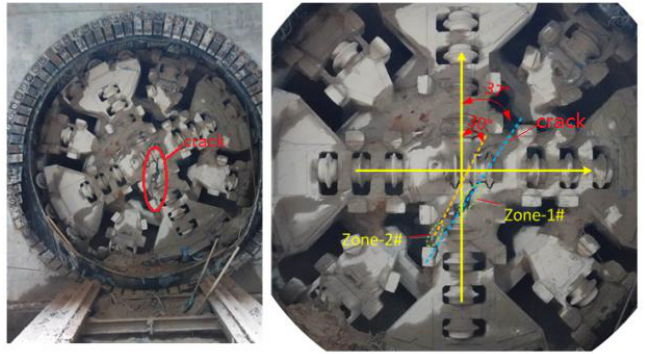
Figure 3. Diagram of cutterhead cracking.